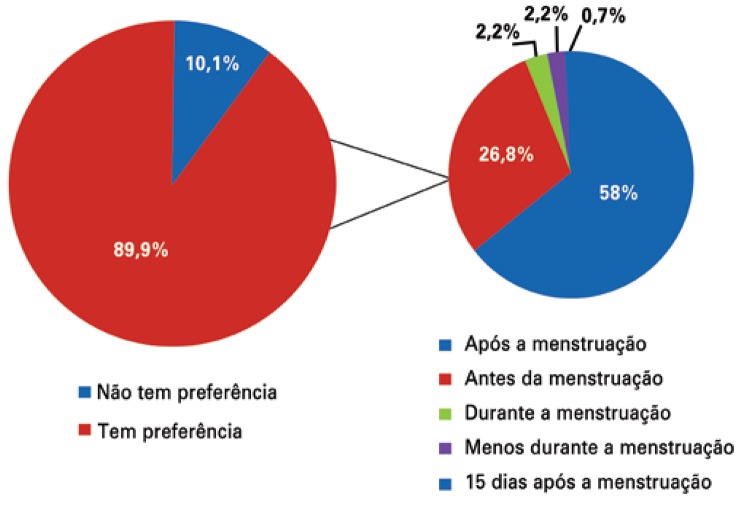
Período do ciclo menstrual em que a atleta prefere competir